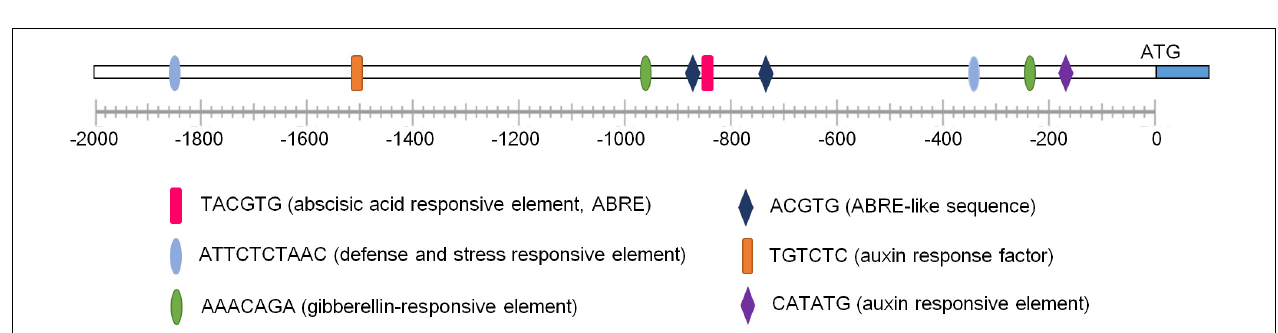
FIGURE 2 | The promoter analysis of GmNARK . The 2 kb DNA fragment upstream of the ATG staring code of GmNARK were analyzed using online analysis software PLACE (http://www.dna.affrc.go.jp/PLACE/) and PlantCARE (http://bioinformatics.psb.ugent.be/webtools/plantcare/html/).